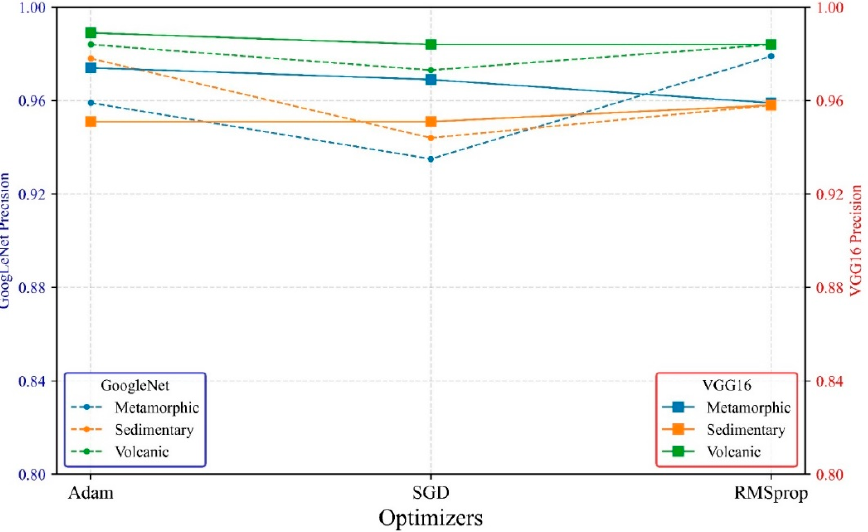
Figure 26. Model precision under three optimizers. The dotted line is GoogLeNet, and the solid line is VGG16.